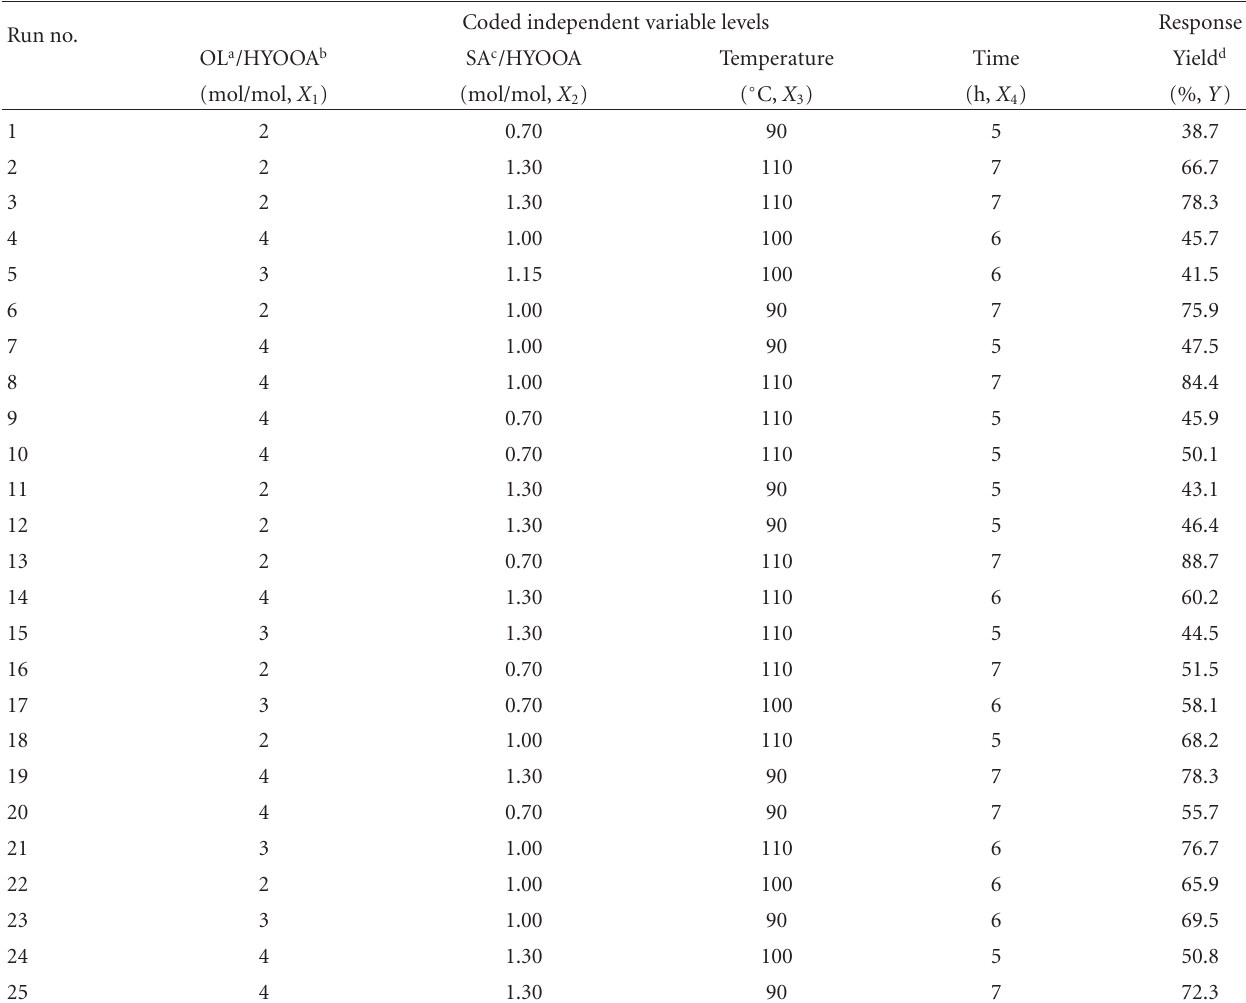
Table 2: D-optimal design arrangement and yield % response of